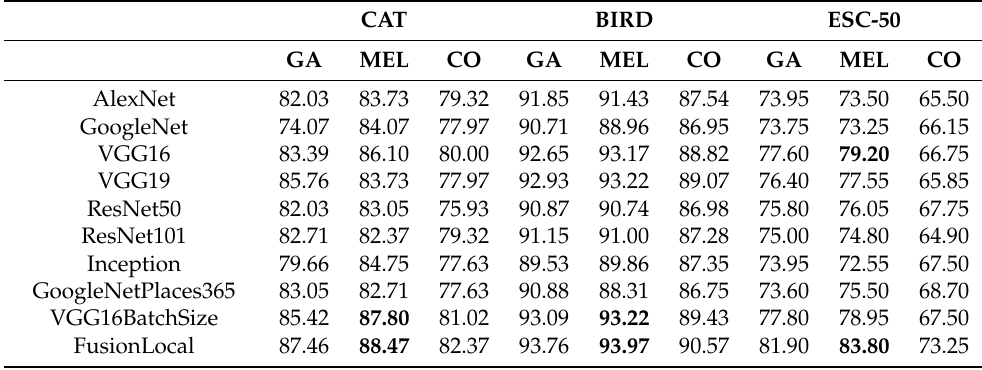
Table 5. Performance using different methods for representing the signal as an image.